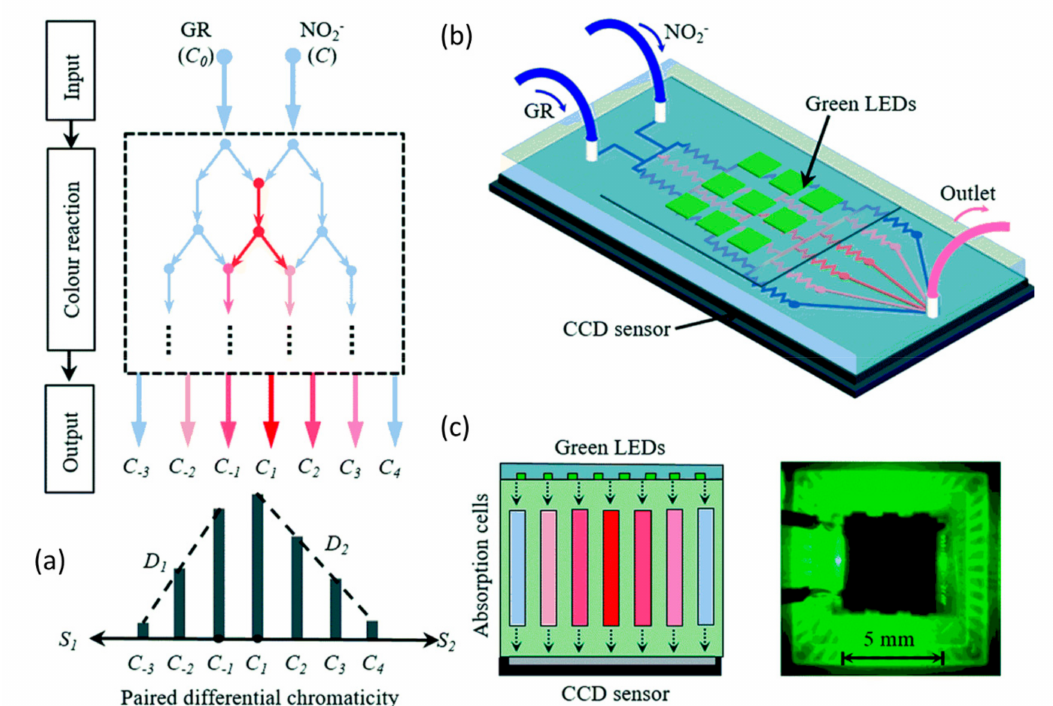
Figure 3. ( a ) Schematic diagram for forming the bidirectional di ff erential concentration. ( b ) Optofluidic platform setup. ( c ) Left: optical detection system with green LEDs and CCD image sensor. Right: physical diagram of the integrated system. Images reproduced from